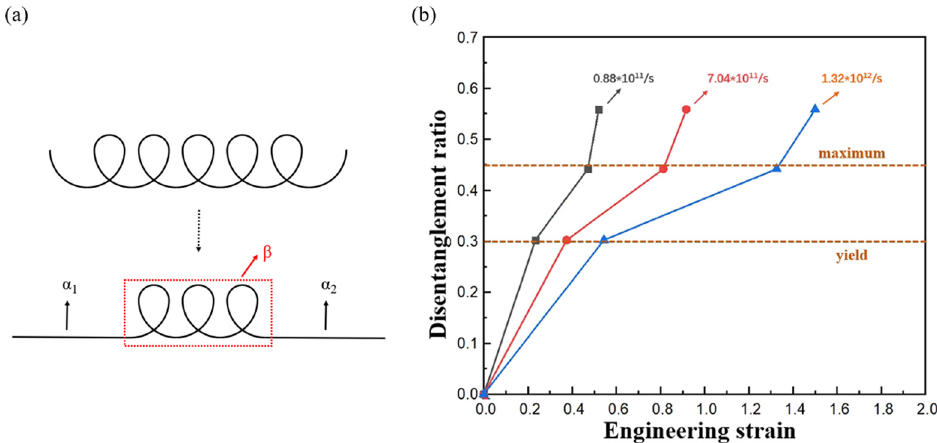
Figure 8: Relation between disentanglement ratio and strain rate of the PTMG system: ( a ) schematic illustration of a molecular chain under dynamic tension loading including the disentanglement part, ( ) = + α α α 1 2 and non - disentanglement part, β , and ( b ) evolution of disen - tanglement ratio with straining at di ff erent strain rates of 0.88 × 10 11 , 7.04 × 10 11 and 1.32 × 10 12 /s.